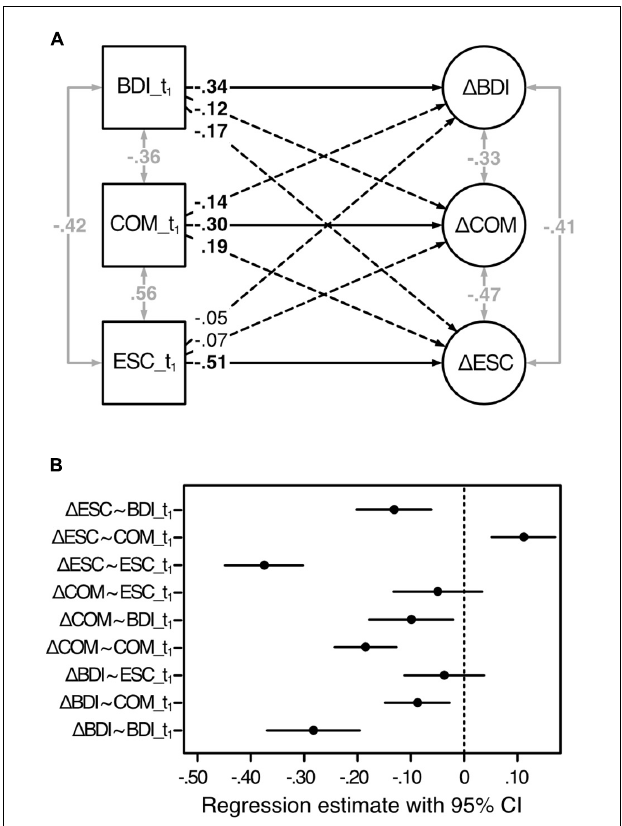
FIGURE 4 | Estimated latent change score model of the change scores predicted by the baseline scores. Analysis based on the second sample ( n 2 = 468). BDI, depressive symptoms; COM, cognitive motivation; ESC, effortful self-control; t 1 , before treatment; (cid:49) , latent change score (i.e., the change from t 1 to t 2 ). (A) Standardized regression coefficients are displayed. One-sided solid and dashed lines refer to the model in Figure 1 and indicate directed effects (regression coefficients), two-sided gray arrows indicate undirected relationships (correlations). Coefficients in bold are significant for p < .05. (B) 95% confidence intervals of the unstandardized regression estimates, based on 1,000 bootstrap samples.